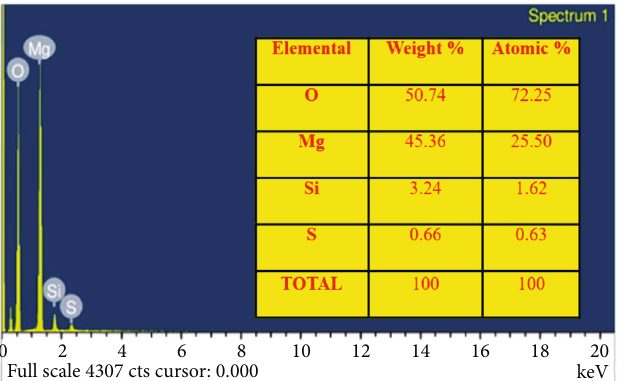
Figure 6: Energy dispersive X-ray spectroscopy image of